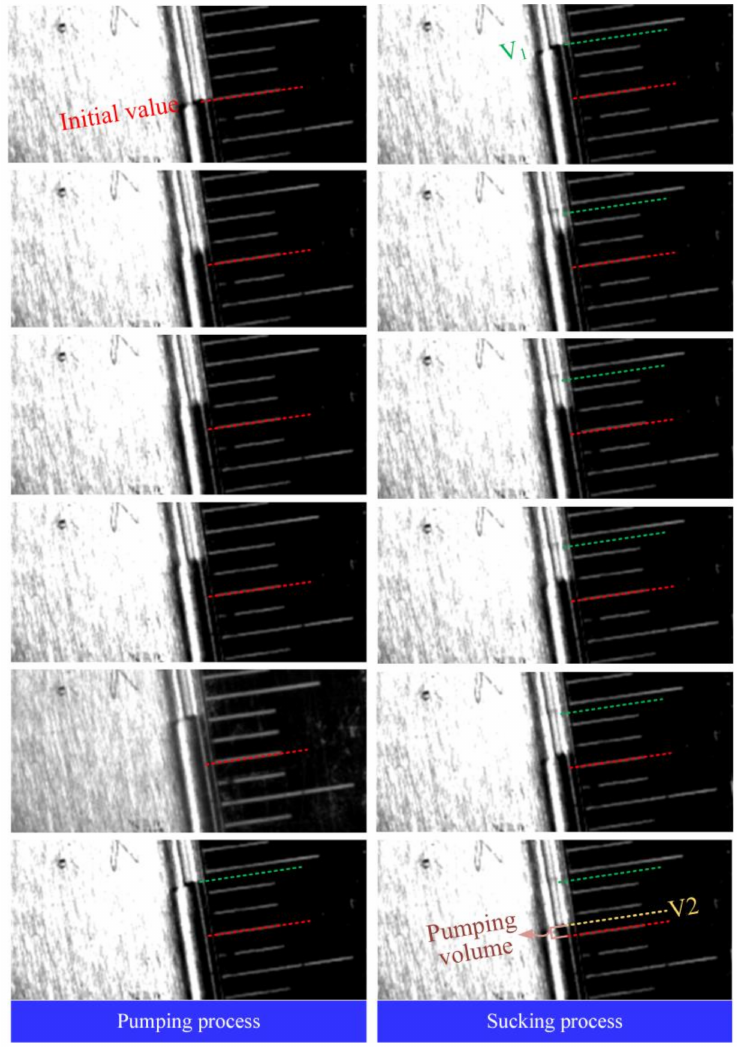
Figure 11. The test pumping statuses at different